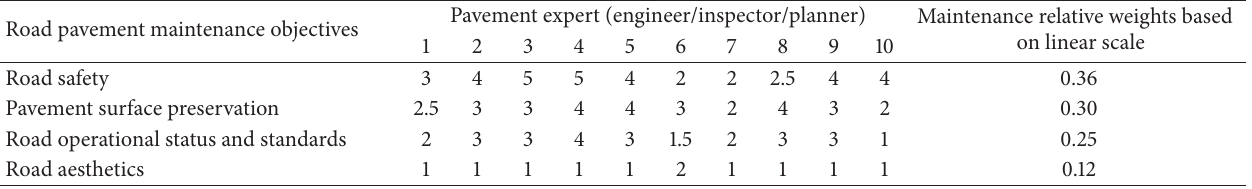
Table 7: Round 3 of decision according to crisp scale based ranking (with 1 being the least important and 5 the most important). Road pavement maintenance